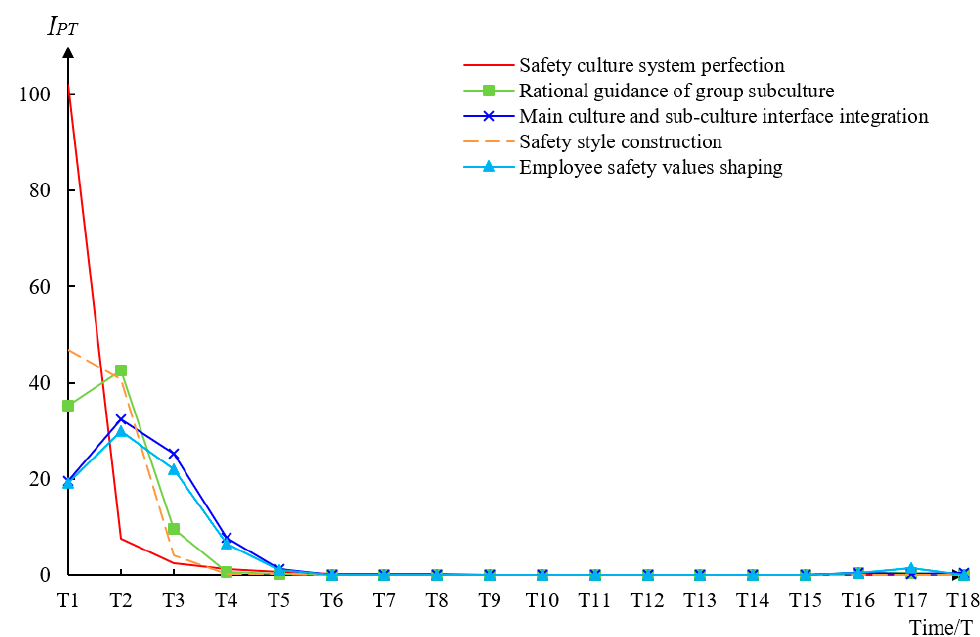
Figure 9. The analysis of I PT change with T based on safety culture.